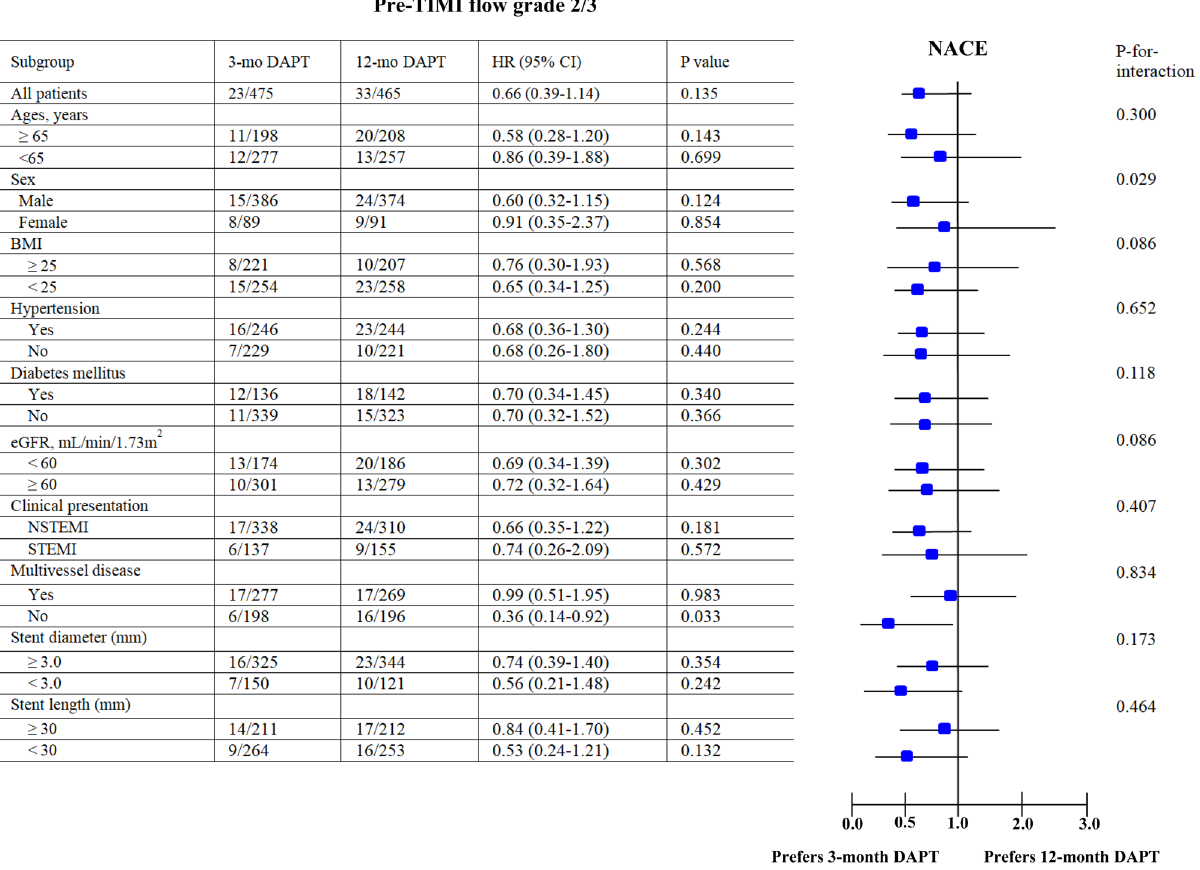
Figure 3. Subgroup analysis for NACE in pre-TIMI flow grade 2/3 group. NACE net adverse clinical event, Pre-PCI pre-percutaneous coronary intervention, TIMI Thrombolysis In Myocardial Infarction, 3-mo DAPT , ticagrelor monotherapy after 3-month dual antiplatelet therapy, 12-mo DAPT ticagrelor-based 12-month dual antiplatelet therapy, HR hazard ratio, CI confidence interval, BMI body mass index, eGFR estimated glomerular filtration rate, NSTEMI non-ST segment elevation myocardial infarction, STEMI ST segment elevation myocardial